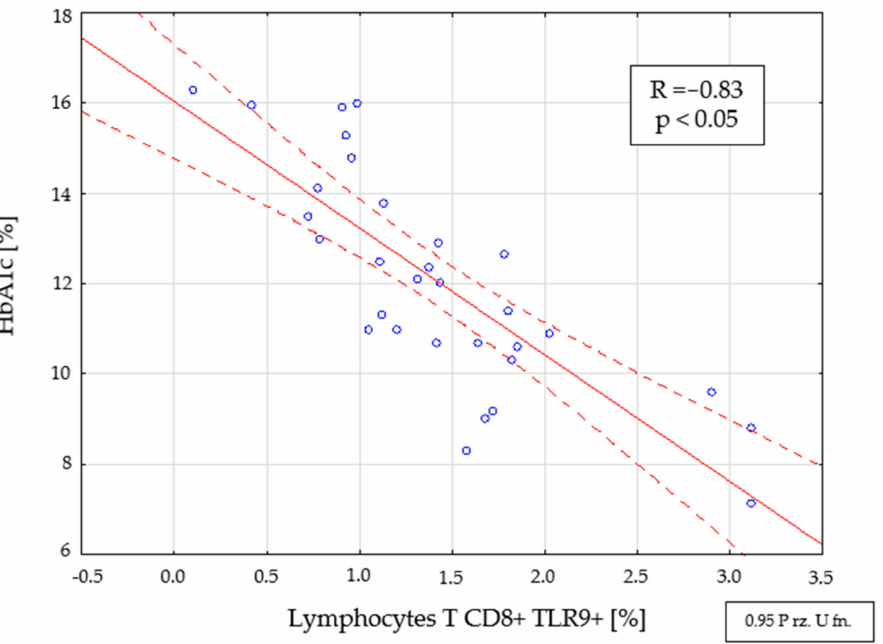
Figure 5. Relationship between the percentage of CD8+ TLR9+ T cells and the level of HbA1c in the group with newly diagnosed type 1 diabetes (<3 months from